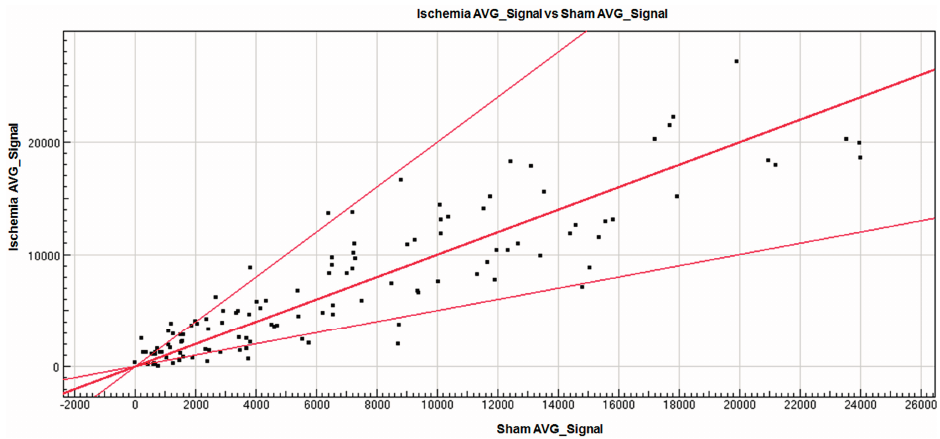
Figure 3. The scatter plots of gene expression pattern in the Ischemia group. Axis X represents the average signals of the sham group, and Axis Y is the average signals of the Ischemia group. Each spot represents the average signal of one gene. Three straight lines represent that the average signal ratios of the spots on the line in the two types of tissues were 2, 1, and 0.5, respectively, from the top to down. The spots above the line of ratio 2 are the significantly up-regulated genes, and spots below the line of ratio 0.5 are significantly down-regulated genes. The farther the spot is from the line, the more significant difference in miRNA expression is.